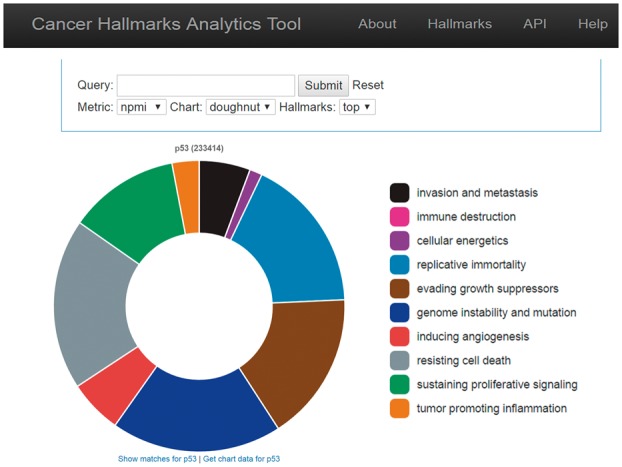
CHAT visualizes the hallmarks distribution for an input query (in this example, ‘p53’). There are several visualization options; in this example, the hallmarks are depicted in a ring akin to the original Hallmarks of Cancer publication (Hanahan and Weinberg, 2000)